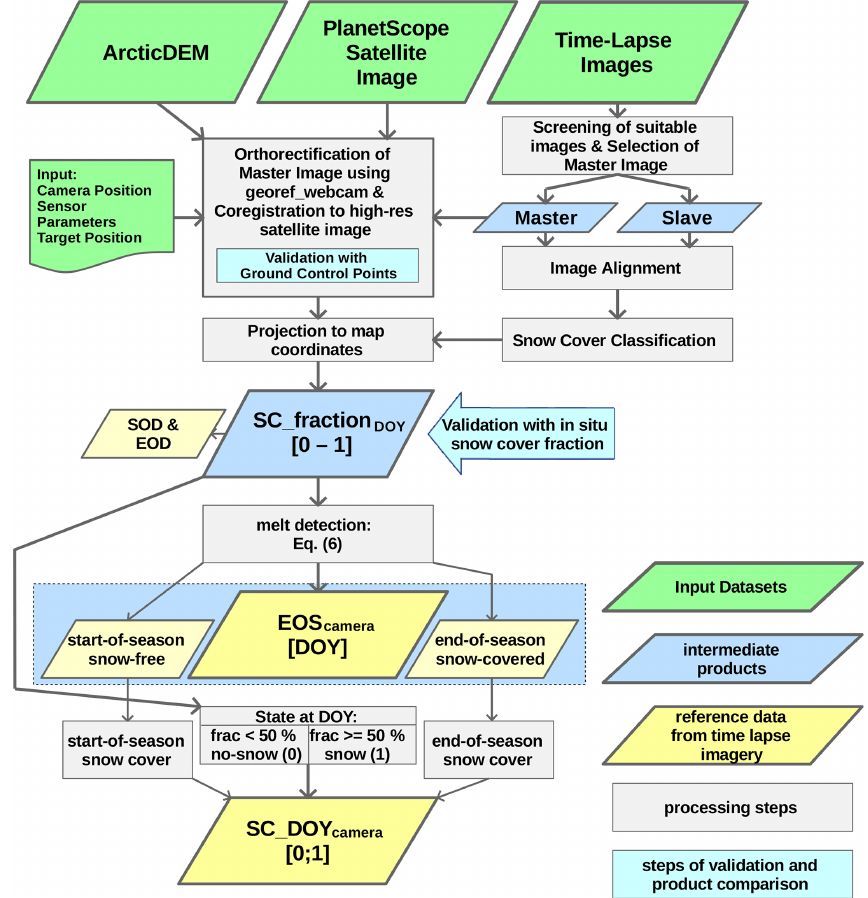
Figure 5. Workflow chart of proposed approach to detect (i) snow cover (SC) and timing of snowmelt as (ii) end of snow cover (EOS) from time-lapse images. EOS (iii) start-of-season snow-free and (iv) end-of-season snow-covered areas are visualized together as so-called melt layer (Figs. 11 and 12), whereas analysis is conducted separately. SOD/EOD: start/end of snow cover decrease, i.e., last DOY, where SC fraction is at 100%, and first DOY, where SC fraction reaches 0%, respectively. SOD and EOD are used for the backscatter–SC-fraction interaction analysis.